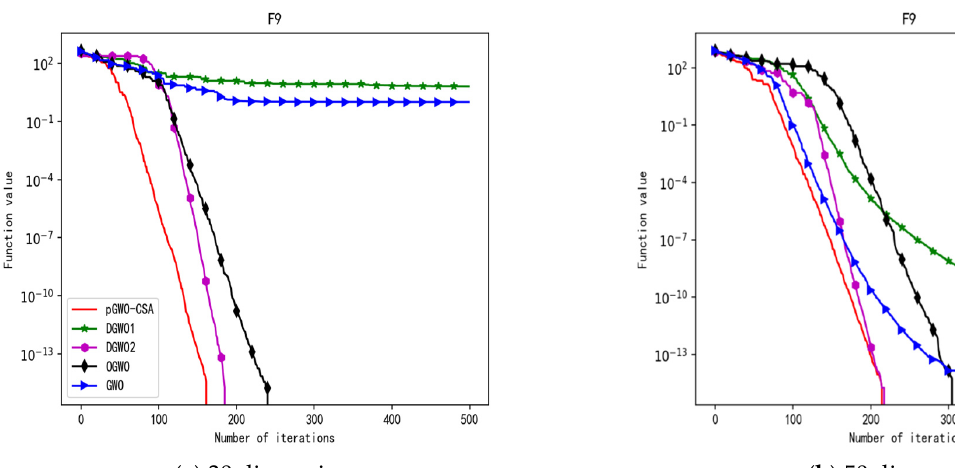
Figure 28. Convergence curve of test function F9.